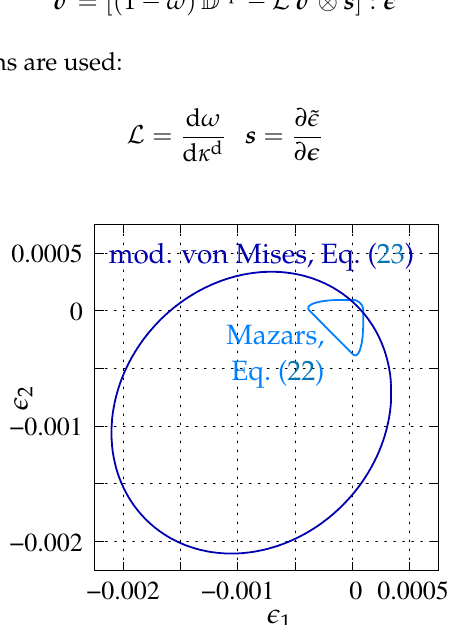
Figure 6. Illustration of equivalent strain measure definitions in 2D principal strain space, plane stress conditions, ν = 0.2, ˜ (cid:101) = 0.00009375, k =